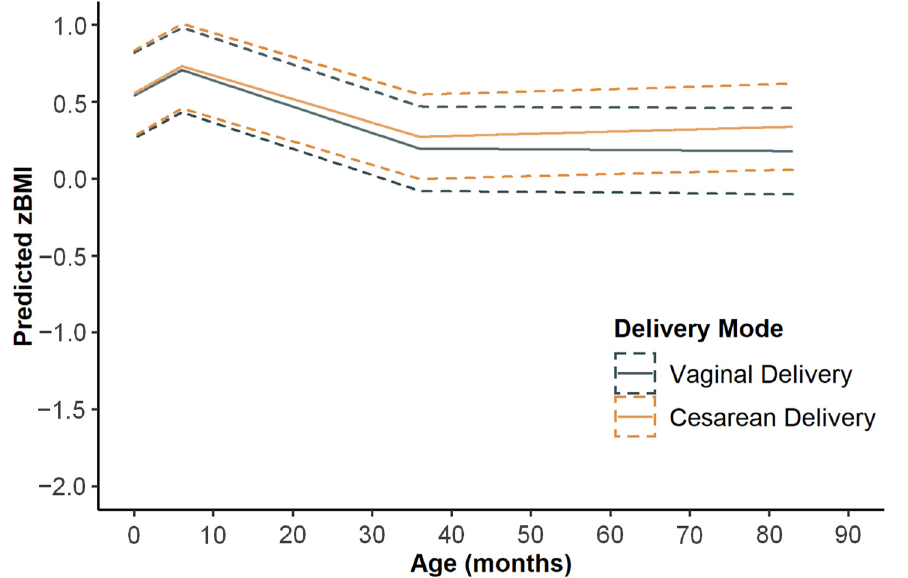
Figure 1. Predicted zBMI growth trajectories (95% CIs) from adjusted analyses by delivery mode. Adjusted for maternal age (<35 years), maternal education (high school or less), annual family income (<10,000 RMB), prepregnancy BMI (<18.5 kg/m 2 ), gestational weight gain (inadequate), gravidity (1), parity (1), gestational age (preterm), child sex (male), birthweight (<2500 g), breastfeeding duration